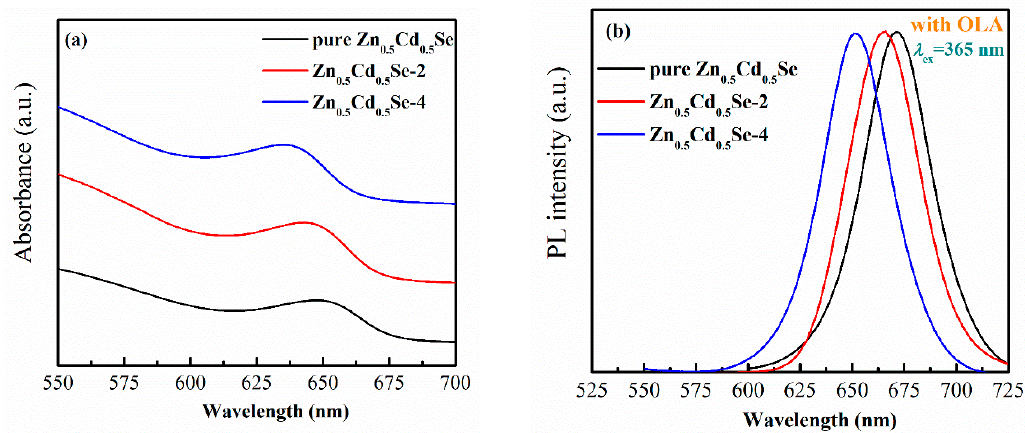
Figure 3. Influence of the low OLA content on the ( a ) UV-vis absorption spectra and ( b ) photoluminescence (PL) spectra of Zn 0.5 Cd 0.5 Se alloy QDs.